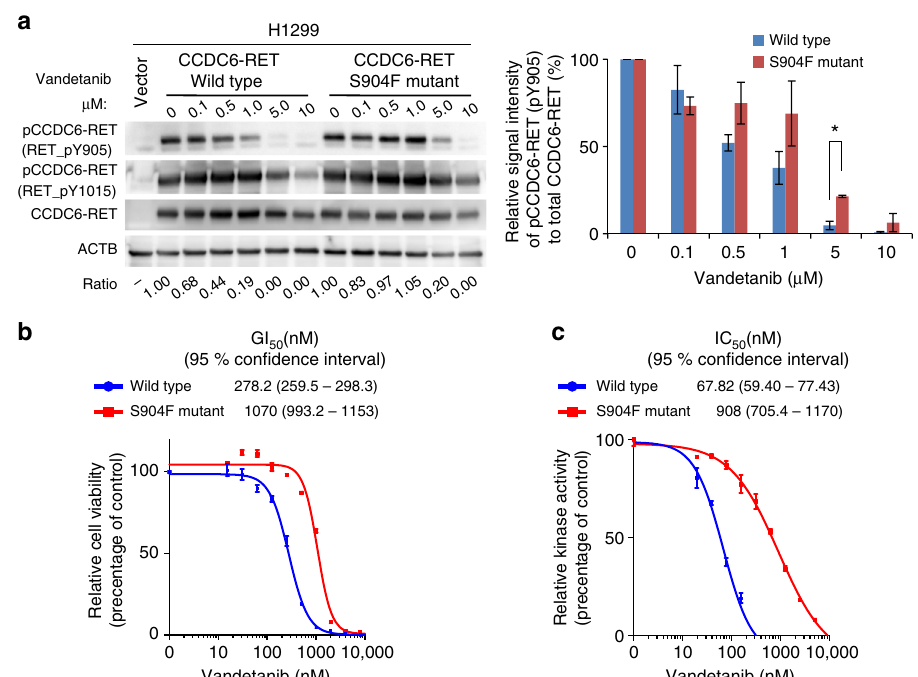
Fig. 2 Resistance to vandetanib by RET-S904F mutation. a Immunoblot analysis of the wild type and S904F mutant CCDC6-RET fusion proteins. (Left) An expression vector encoding full-length wild type or S904F mutant CCDC6-RET cDNA was transiently introduced into H1299 lung cancer cells. After exposure to the indicated concentrations of vandetanib for 6 h, phosphorylation at tyrosines 905 and 1015 were detected. The signal intensities, calculated as the ratio of phosphorylated to total CCDC6-RET fusion proteins, are shown at the bottom. (Right) The experiment (shown on the left) was performed separately three times (Supplementary Fig. 8). The graph shows the mean ratios of phospho-Ret (pTyr905) to total RET from three separate experiments with standard deviations (shown as error bars). Concentrations showing statistical signi fi cance ( p < 0.05 by t -test) are marked with an asterisk. ACTB: beta-actin. b Cell growth assay using IL3-independent Ba/F3 cells carrying lentivirally transduced CCDC6-RET cDNA with or without the S904F mutation. Ba/F3 cells (2000 cells) were plated in quadruplicate in 96-well plates and treated with serially diluted vandetanib. After incubation for 72 h, cell viability was measured using the CellTiter-Glo luminescent reagent with EnVision and the viability curves with standard deviations (shown as error bars) were calculated with GraphPad Prism version 6.0. Reproducibility was con fi rmed by performing the same experiment three times. c In vitro kinase assays. Recombinant RET kinase domain (KD) (amino acids 658 – 1072) with or without the S904F mutation was expressed by baculovirus in Sf9 insect cells using an N-terminal GST tag (gene accession number: NM_020630). The assay was initiated by addition of 32 P-ATP to the reaction mixture and serially